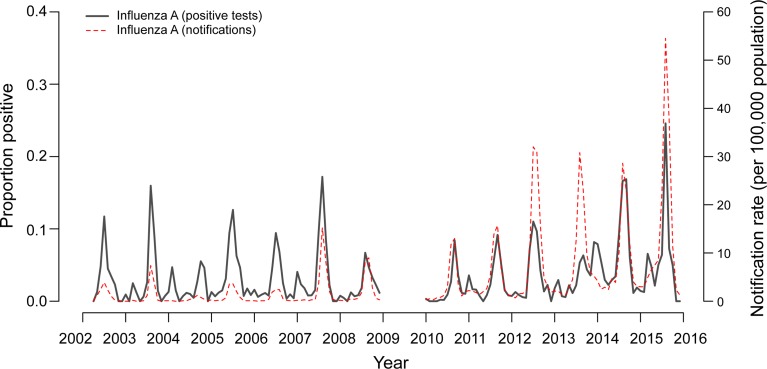
Two-week moving averages of weekly positive rates for influenza A compared to Victorian notification rates. Notification rates during seasons with high incidence of influenza (June–September 2014 and 2015) were scaled down 2:1 to allow better visualisation of inter-epidemic peaks. Data from 2009 were omitted as the influenza pandemic resulted in changed referral patterns.